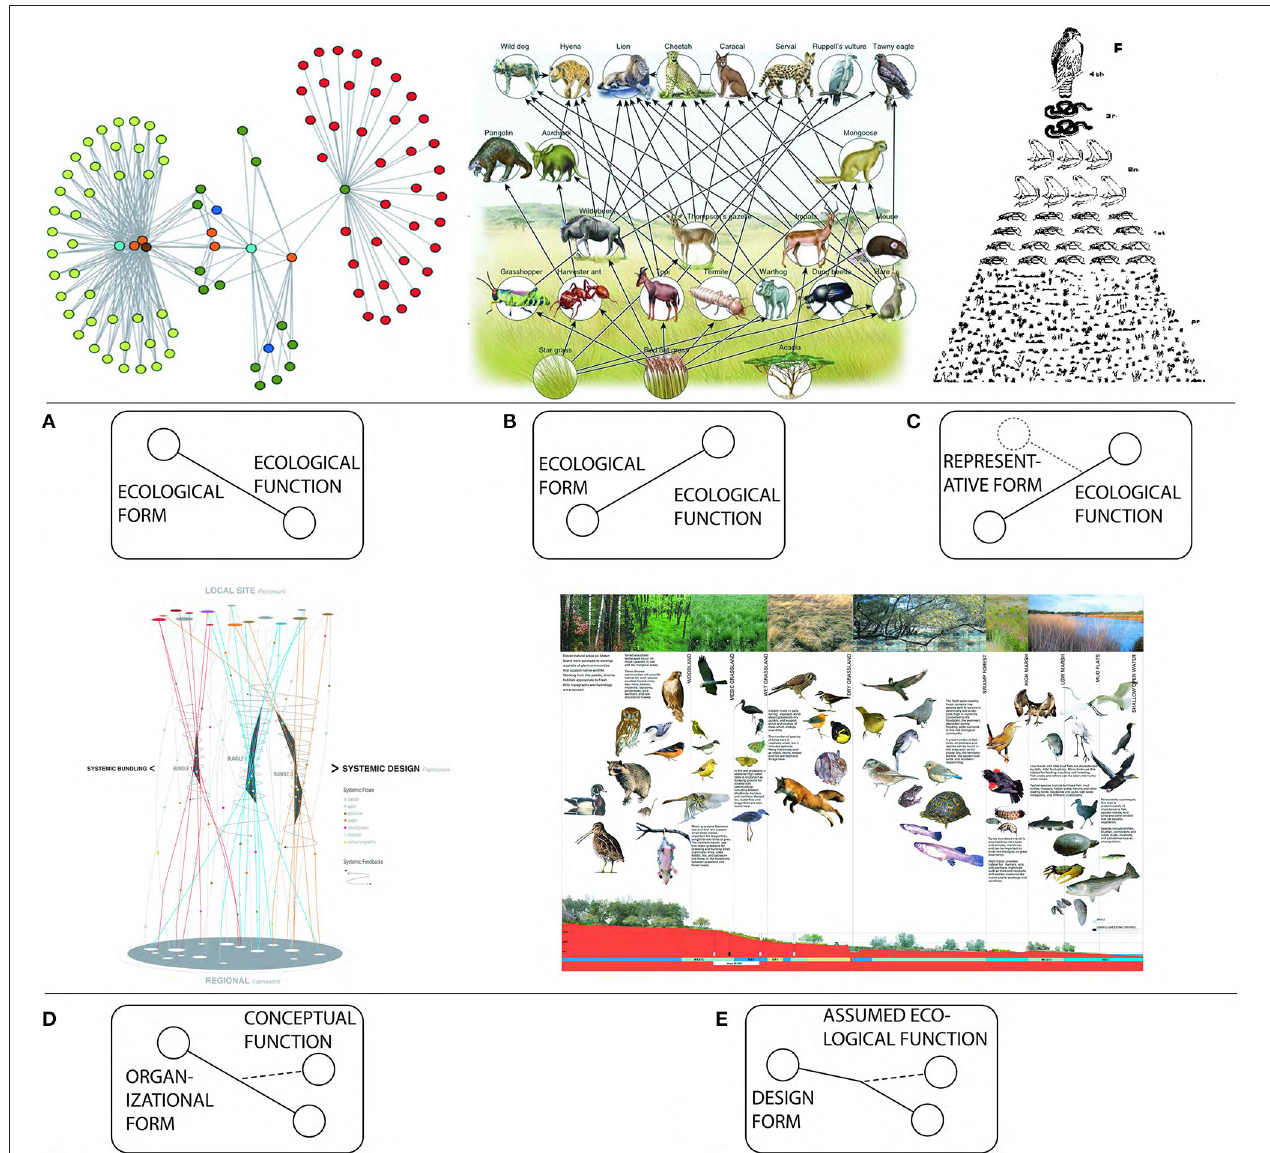
FIGURE 1 | Food webs as envisioned by ecologists and designers place different emphases on their structure (form) and dynamics (function or ecosystem services). The large color panels illustrate portrayal by ecologists of food webs (A,B) and their pedagogical representation (C) ; and their physical embodiment by designers and landscape architects for the built environment (D,E) . The “see-saw” icon below each color panel indicates the relative emphasis on form and function in the associated panel. Form (on the left) or function (on the right) may be emphasized (upper left or right) or de-emphasized (lower left or right) and there is usually (but not always, as in C ) a trade-off (see-sawing) between form and function in emphasis by ecologists or designers. For additional discussion and illustration, see, respectively main text section 6.4 and sliders below photographs in Figure 10 . (A) Is an abstraction of a food web that illustrates its topology. Colored nodes identify functions (e.g., producer, consumer) but there is no identification of who eats whom, directionality, or interactions. (B) Is an illustration of a food web that emphasizes functions (as interrelationships across organisms and trophic structures) using directional arrows to indicate who eats whom. (C) Is a “food pyramid” like those seen in high-school textbooks that emphasizes trophic transfer and the decreasing abundance of individuals at increasingly higher trophic levels. (D) Illustrates a “Systemic Design” framework for managing interactions and information translated across scales in a hierarchy of nested relationships. Information is bundled into clusters (“Systemic Bundles”) that tie local site conditions to regional perspectives and expose issues surrounding any given site. (E) Is a design-based representation by James Corner Field Operations of an idealized process of ecological succession and food-web development in an urban landfill-turned-public park. Image sources: (A) Image produced with FoodWeb3D , and provided by the Pacific Ecoinformatics and Computational Ecology Lab (http://www.foodwebs.org/; Yoon et al., 2004); (B) Savanna food web from https://savannabiomeassignment.weebly.com/food-web.html; (C) Image in the public domain from Brace (1977); (D) Alan M. Berger and Casey L. Brown, P-REX, published in Berger (2009) and used with permission; (E) James Corner Field Operations, and used with permission.